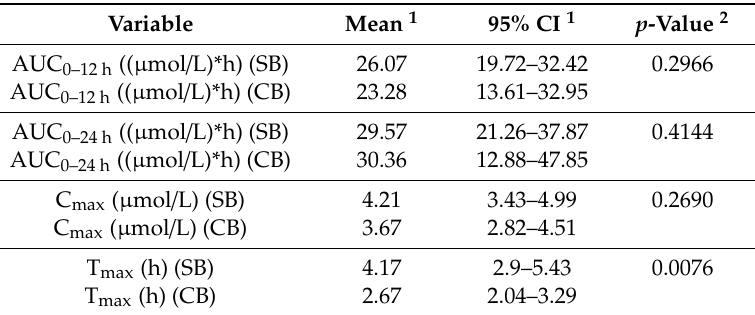
Table 2. Pharmacokinetic parameters of choline.